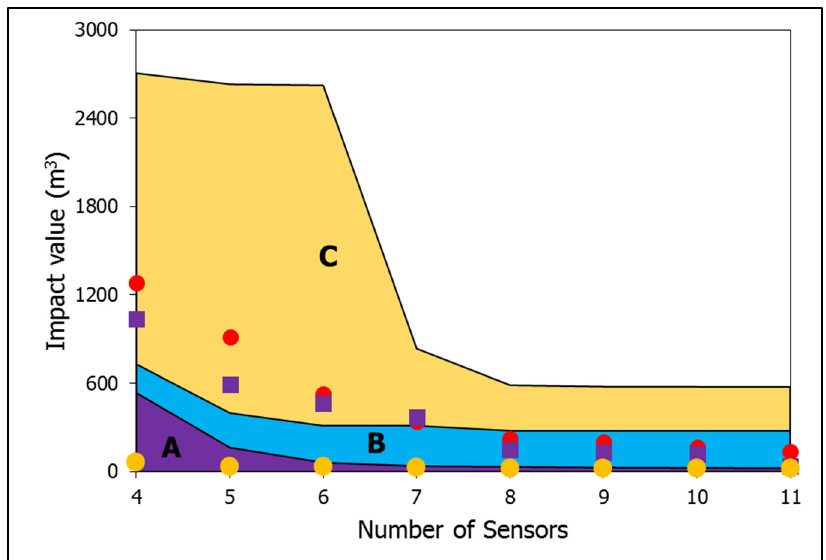
Figure 7. Impact values corresponding to normal and cyber-physical attack scenarios for the OCMS with η total = 4, 5, . . . , 11. The yellow circles signify the mean impact value under a normal scenario. The red circles and violet squares indicate the mean and median impact values under cyber-attack scenarios, respectively. The violet region (A) denotes the area between the minimum impact values corresponding to normal and cyber-physical attack scenarios. The blue region (B) signifies the area between the maximum impact values corresponding to normal scenarios and minimum impact values corresponding to cyber-physical attack scenarios. The yellow region (C) denotes the area between the maximum impact values corresponding to normal and cyber-physical attack scenarios.